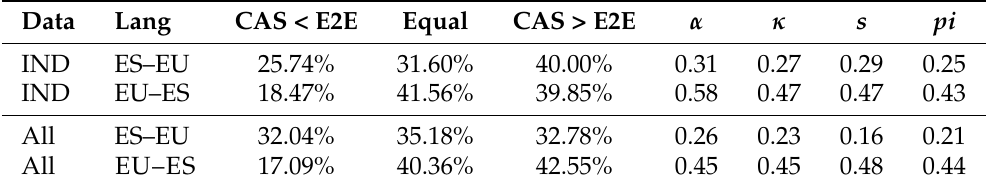
Table 14. Cascade vs. end-to-end 3-way ranking results. α indicates Krippendorff’s alpha; κ : Fleiss’s Kappa; s : Bennett’s S; pi : Scott’s